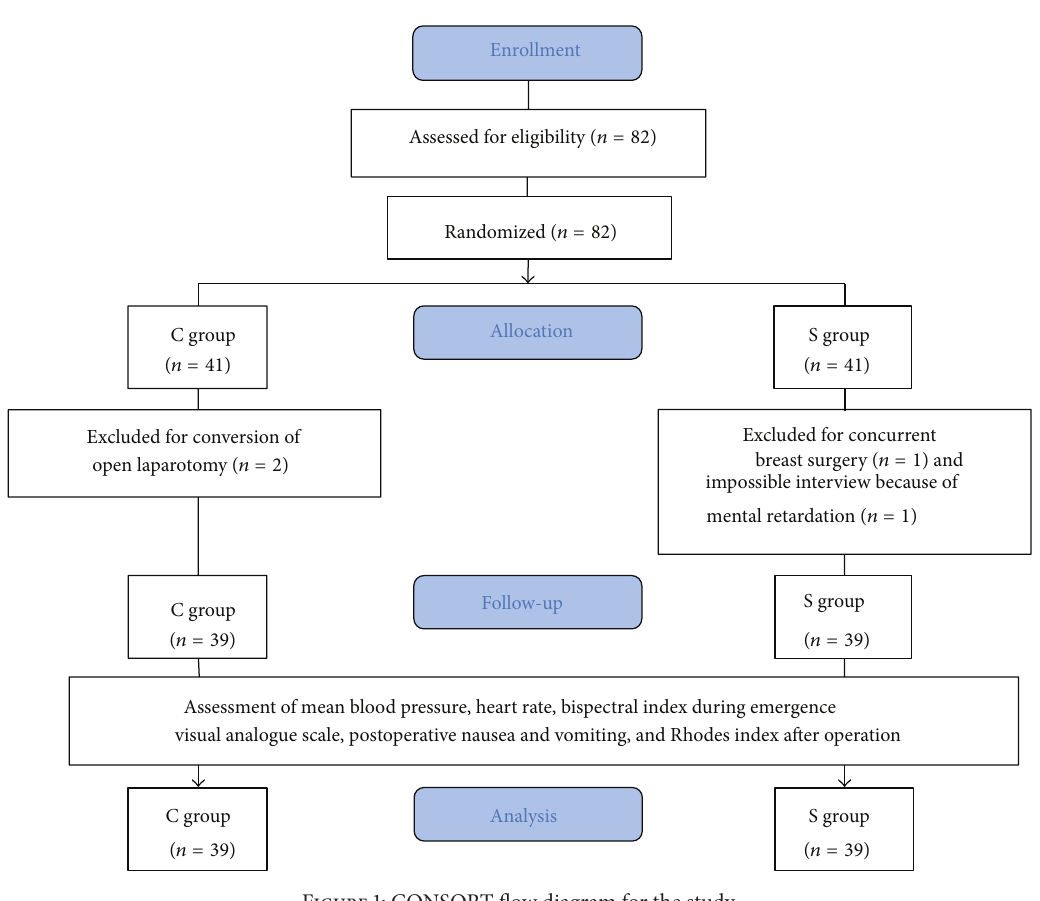
Figure 1: CONSORT flow diagram for the